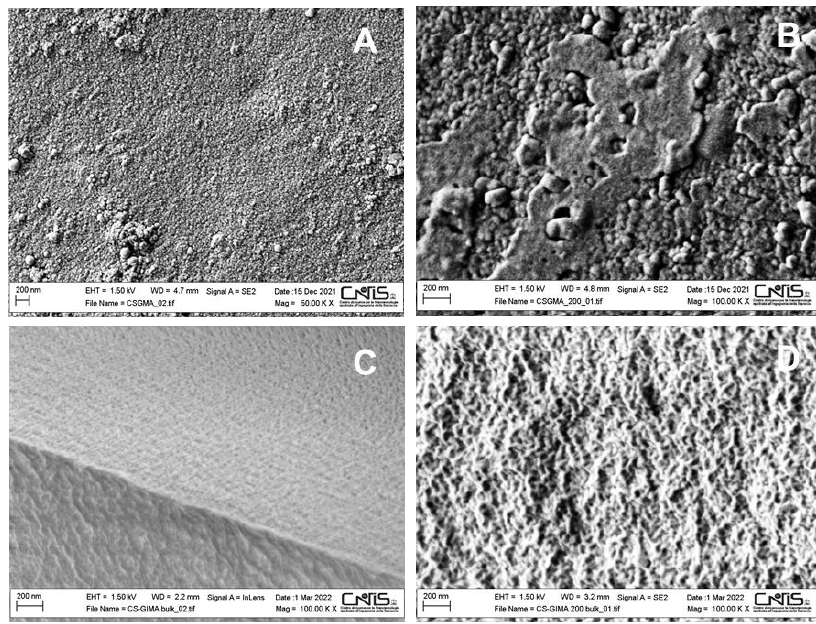
Figure 3. SEM images of the surface ( A ) and bulk ( C ) of CS_GMA, and surface ( B ) and bulk ( D ) of CS_GMA_5.